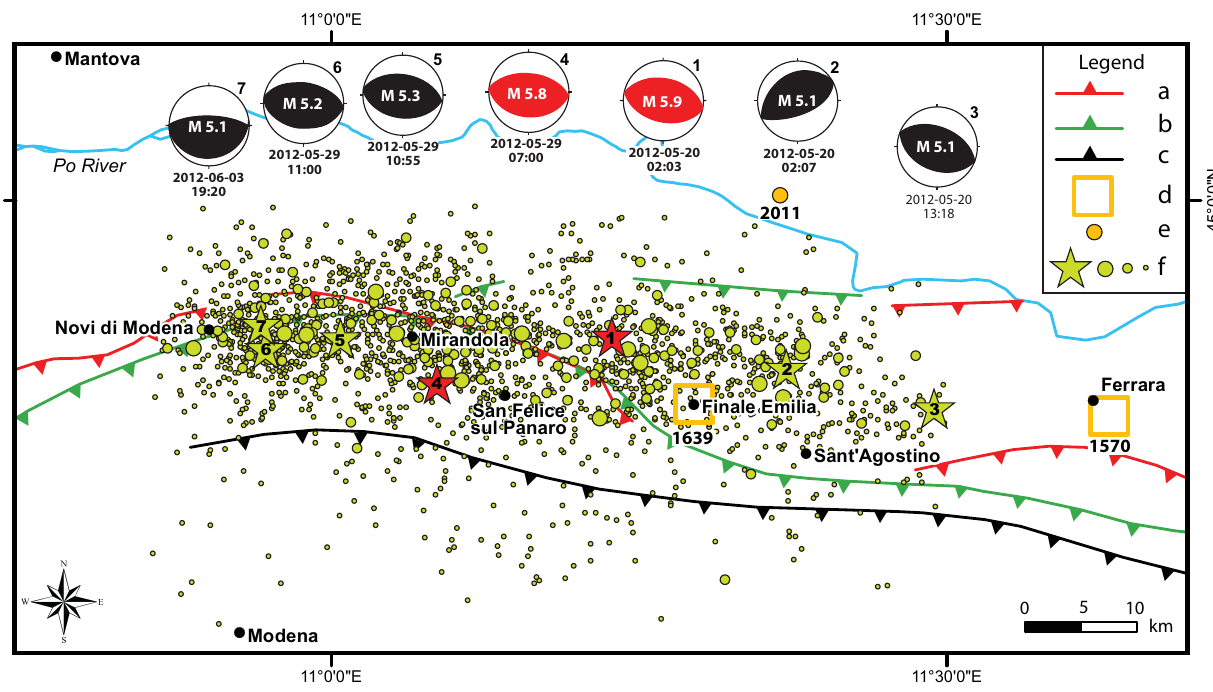
Fig. 2. Area of the Emilia 2012 earthquake sequence. (a), (b), (c) main active structures from Boccaletti and Martelli (2004), see caption of Fig. 1; (d) historical earthquakes with M e ≥ 5 (CPTI11 Catalogue, Rovida et al., 2011); (e) M L 4.8, 2011 event and (f) Emilia 2012 sequence (ISIDe Database, 2012): stars stand for M L ≥ 5.0 earthquakes (in red the two mainshocks) and numbers refer to focal mechanisms (Scognamiglio et al., 2012); circles of variable size are for earthquakes of M L = 4.1 ÷ 4.9, M L = 3.1 ÷ 4.0 and M L ≤